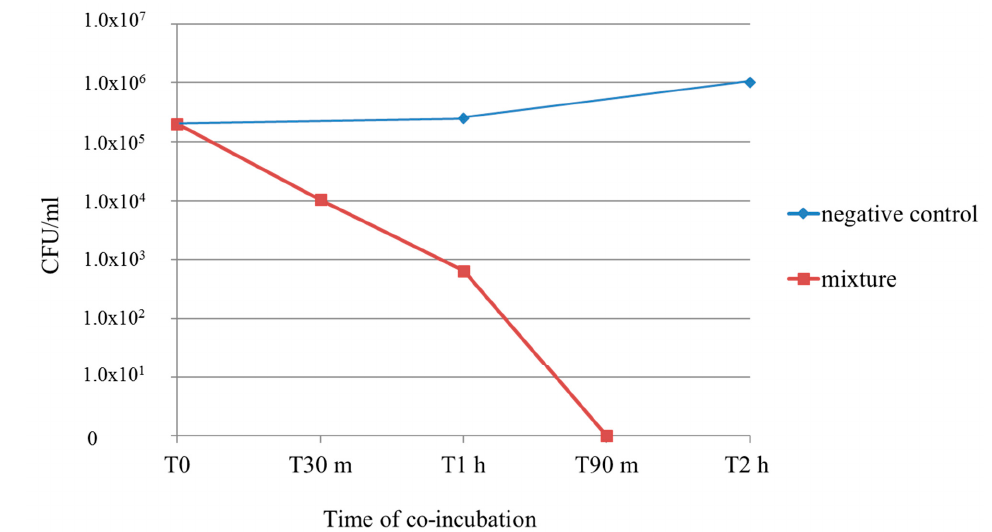
Figure 3. Time–kill curve for C. albicans strain number 15. The mixture of cinnamaldehyde/eugenol was tested at the MFC of the combination (2 × MIC of combination in this case). MIC: minimal inhibitory concentration. MFC: minimal fungicidal concentration. CFU: colony-forming unit. h: hours. m: minutes. Negative control: no compounds were added to the cell suspension.